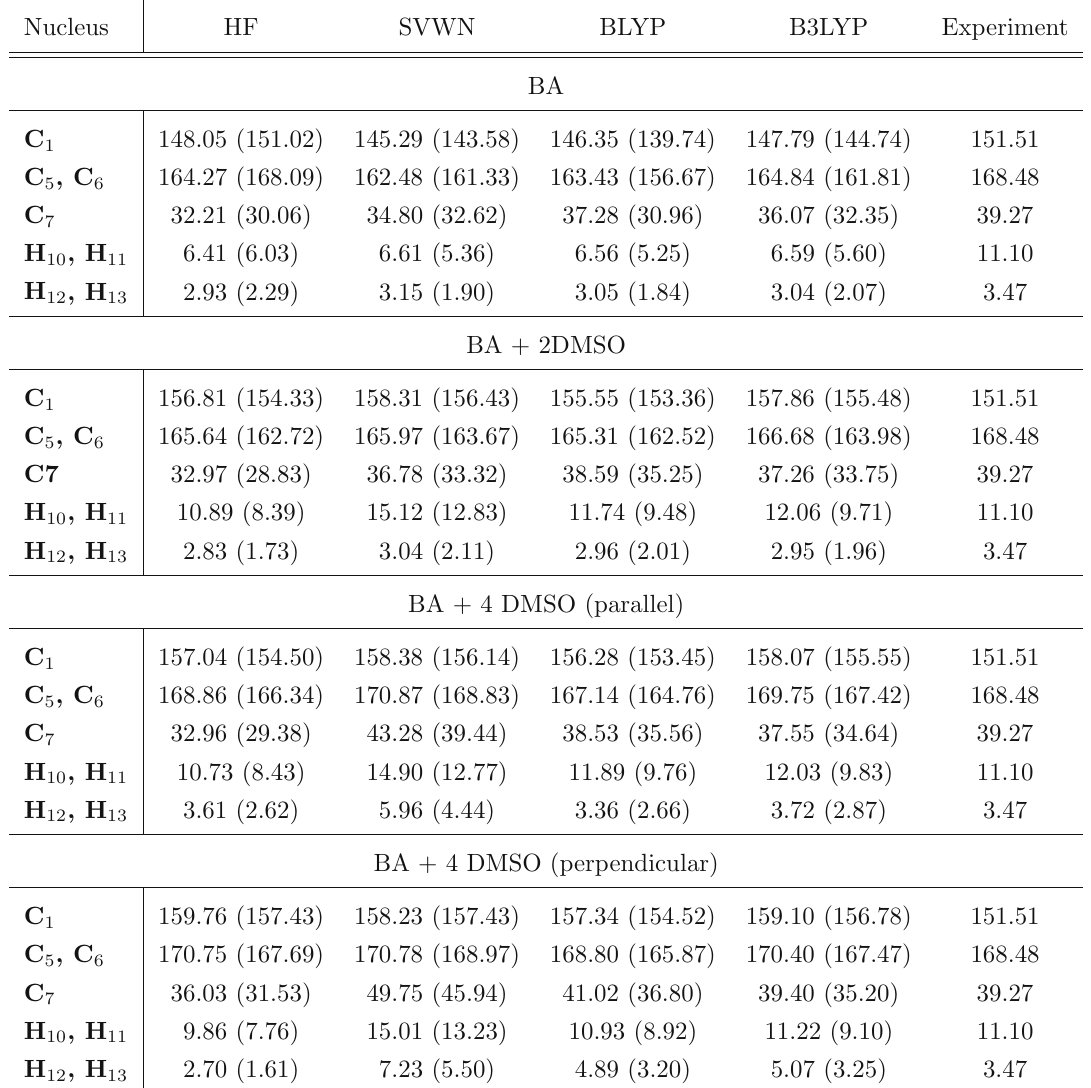
Table 1 Theoretical GIAO and CSGT (in parentheses) chemical shifts of barbituric acid and its complexes in the 6-311++G(d,p) basis